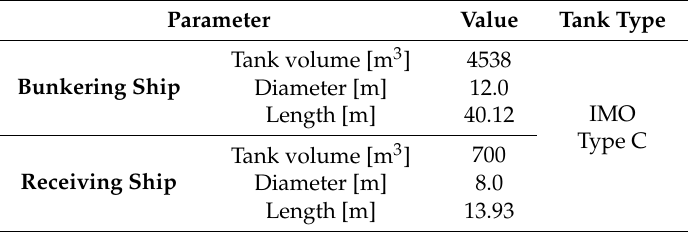
Table 1. Geometry for the LNG tanks of bunkering and receiving ships.